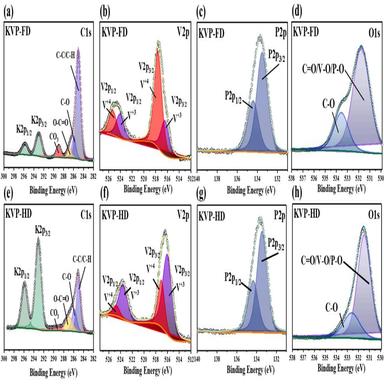
C1s-K2p, V2p, P2p and O1s spectrum of KVP-FD and KVP-HD materials.